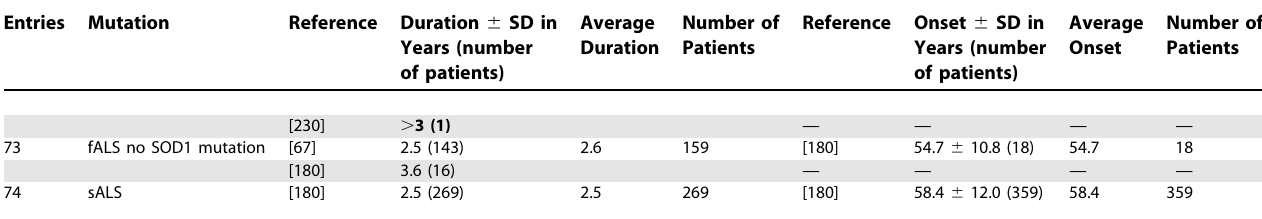
Figure S1. Lack of Correlation between SOD1 Aggregation Propen- sity and SOD1 Instability The same dataset for fALS-associated SOD1 mutations shown in Figures 3 and 4 were considered. The predicted aggregation propensities and instabilities from 28 different fALS-causing SOD1 mutations were plotted using the software SigmaPlot 9.0 (Systat Software, Inc.). Figure S2. Little or No Correlation between SOD1 Aggregation Propensity, SOD1 Instability, or the Sum of Aggregation Propensity and Instability with fALS Patients’ Age of Onset The relationship between SOD1 aggregation propensity (A, D), instability (B, E), or sum of aggregation propensity and instability (C, F) with fALS patients’ age of onset are presented. The linear regressions presented in (A–C) were weighted by the number of patients for each mutation using SPSS version 15.0 (SPSS, Inc.). The correlation between the size of each data point and the number of patients for (A-C) is shown as an inset in (C). The linear regressions presented in (D–F) were treated equally regardless of the number of patients for each mutation (unweighted) using the software SigmaPlot 9.0 (Systat Software, Inc.). The age of onset data presented in these six graphs are from 649 patients with 29 different fALS- causing SOD1 mutations with reported stability values. Aggregation propensity, instability, and sum of aggregation propensity and instability were obtained as described in the Materials and Methods section. Aggregation propensity, instability, or sum of aggregation propensity and instability has little or no correlation with patients’ age of onset. Found at doi:10.1371/journal.pbio.0060170.sg002 (261 KB